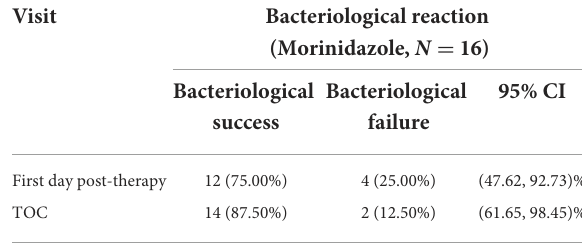
TABLE 4 Bacteriological success in the MBV population at the TOC visit.